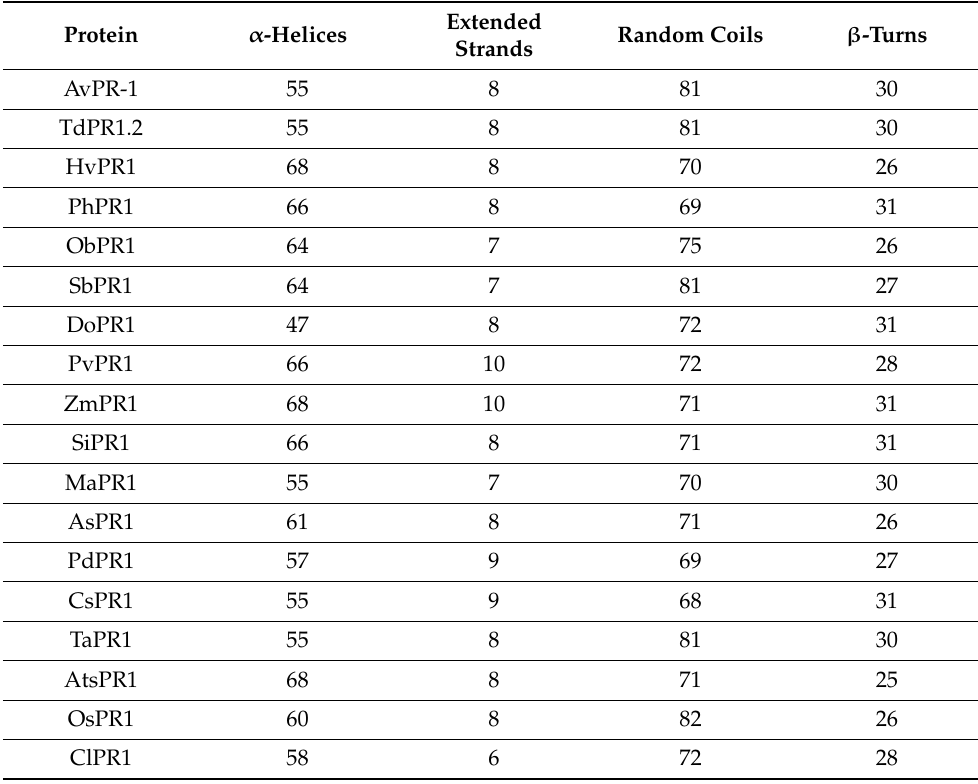
Table 2. Secondary structure analysis of AvPR-1 and other plant PR-1 using SOPMA program.